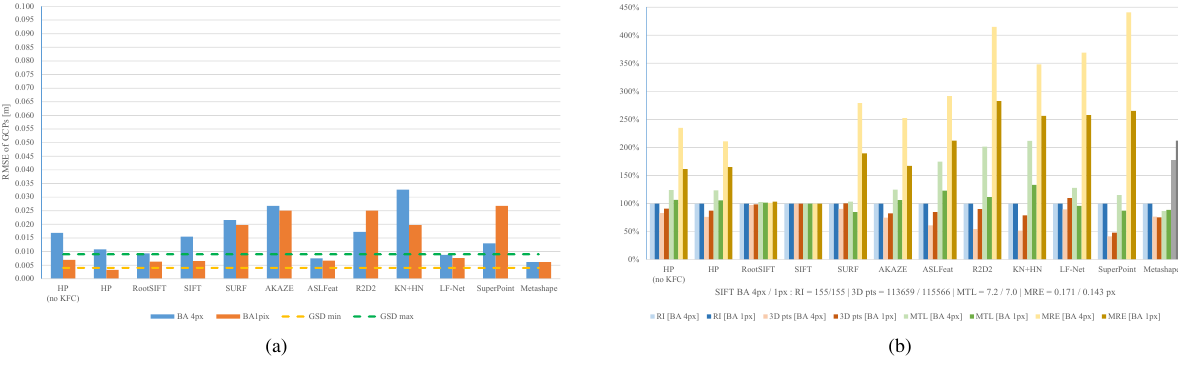
Figure 11. Paestum Wall Full dataset: (a) RMSEs of the CPs and (b) BA statistics as percentages with respect to SIFT values (OPENCV camera model with PP post-refinement, mTL=3). The min and max GSDs are reported with respect to the downsampled images. serving the rotation invariance. This design makes our hybrid pipeline modular, flexible and capable of exploiting new deep- learning descriptors which are not natively rotational